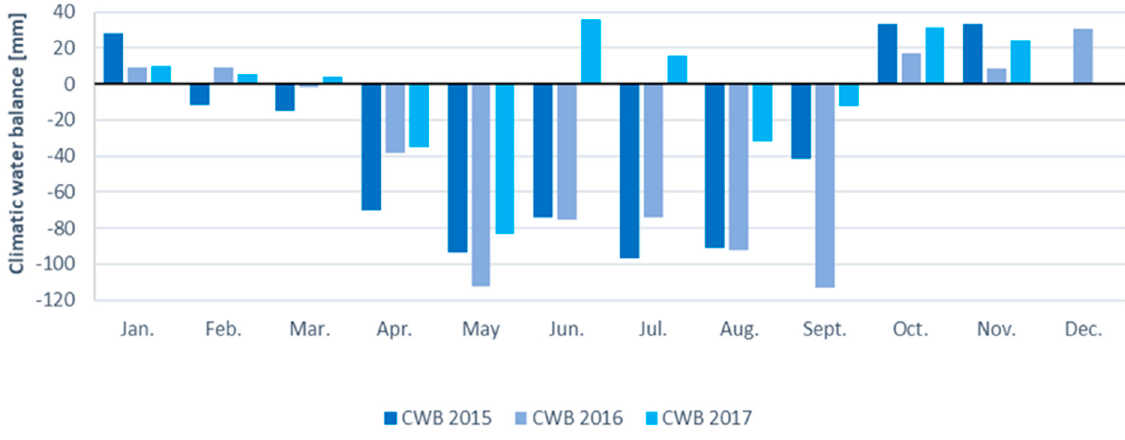
Figure 1. Climatic water balance for 2015, 2016 and 2017.